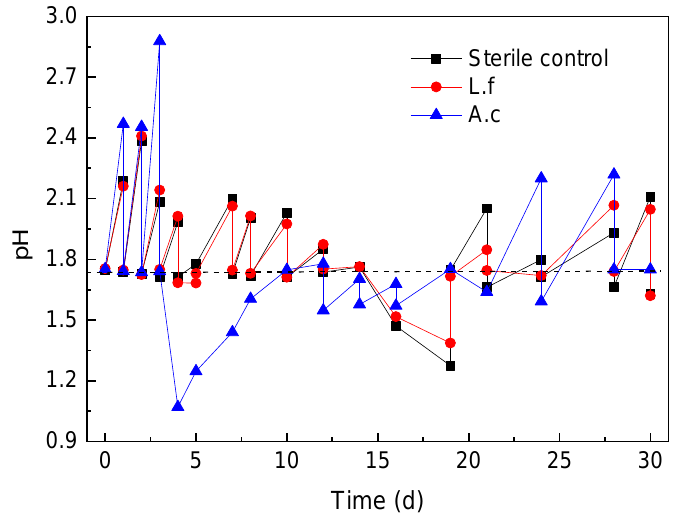
Figure 4. Variations of pH during bornite bioleaching by L. ferriphilum , A. caldus, and sterile control.